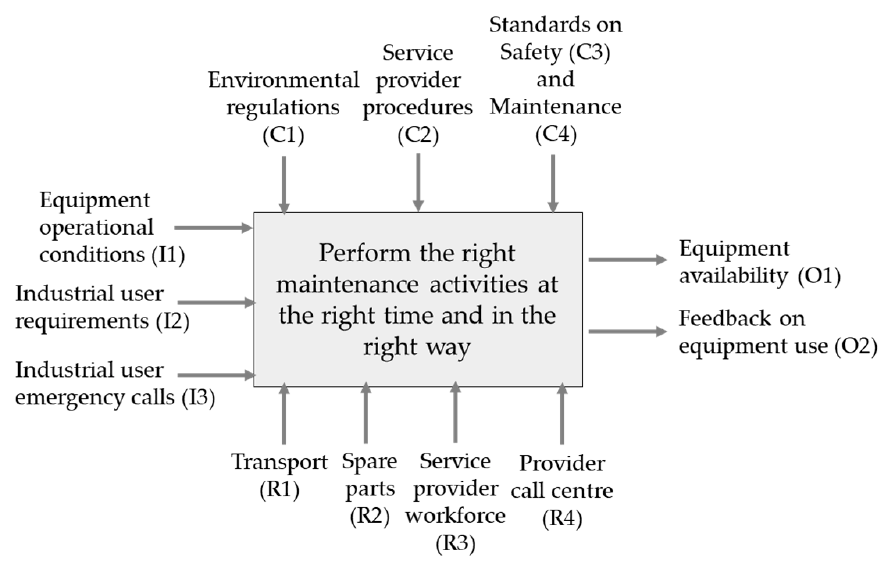
Figure 1. Integration Definition for Function Modeling (IDEF0) high-level diagram for performance-based maintenance service (PBMS).